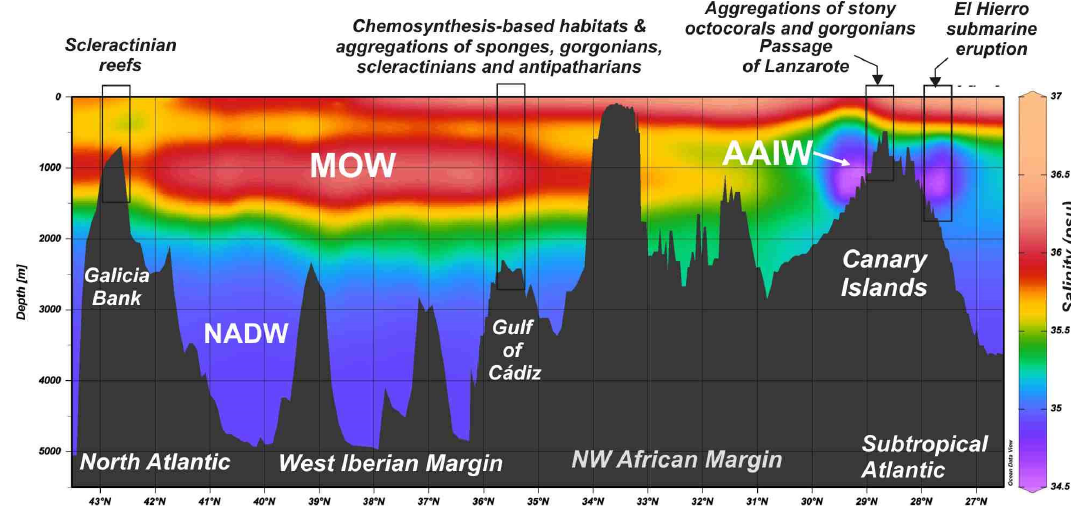
Figure 12. Distribution of water masses from the Subtropical Atlantic to the North East Atlantic based on regional salinity values. Mediterranean Outflow Waters are mainly flowing northwards from the Gibraltar Strait affecting the Gulf of Cádiz and west Iberian Margin. Otherwise, Antarctic Intermediate Waters are flowing northwards along the NW African Margin throughout the Passage of Lanzarote. Data from World Ocean Database 2018 [44].